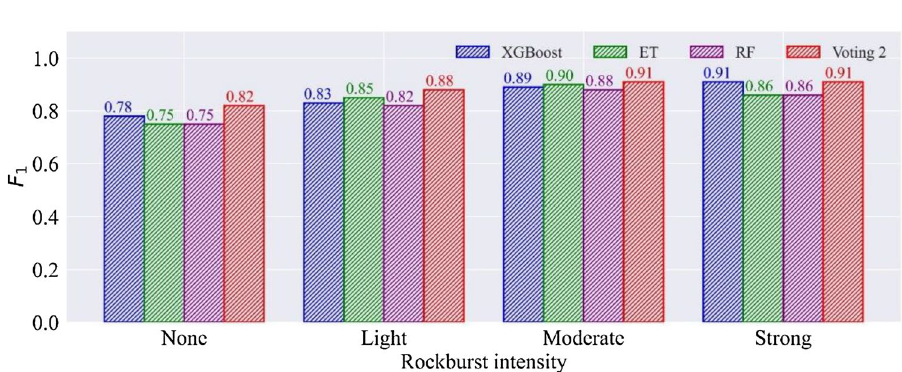
Figure 11. The comparison of F 1 in voting 2 model and its base